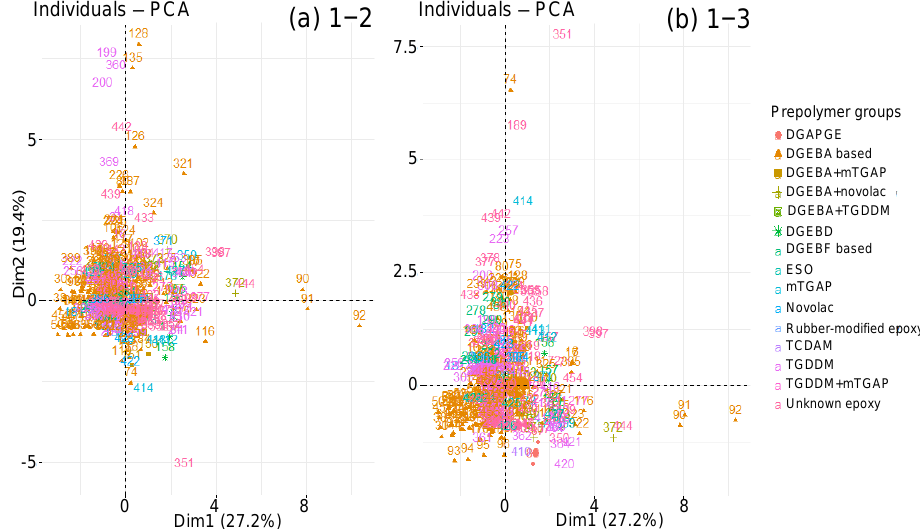
Figure 10. Graphs of individuals on planes ( a ) 1–2 and ( b ) 1–3 of the global PCA, according to prepolymer type.